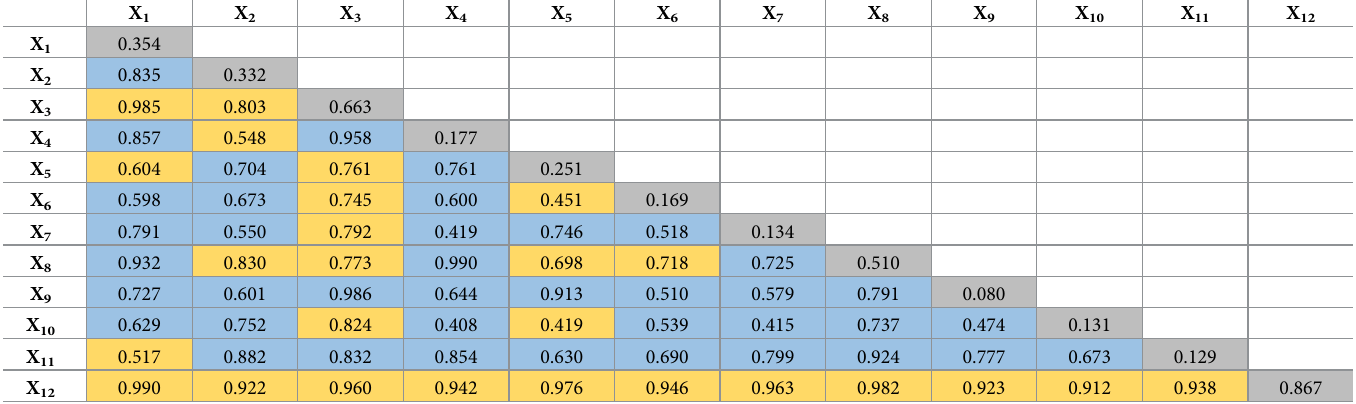
Table 6. Influence of factors interaction.